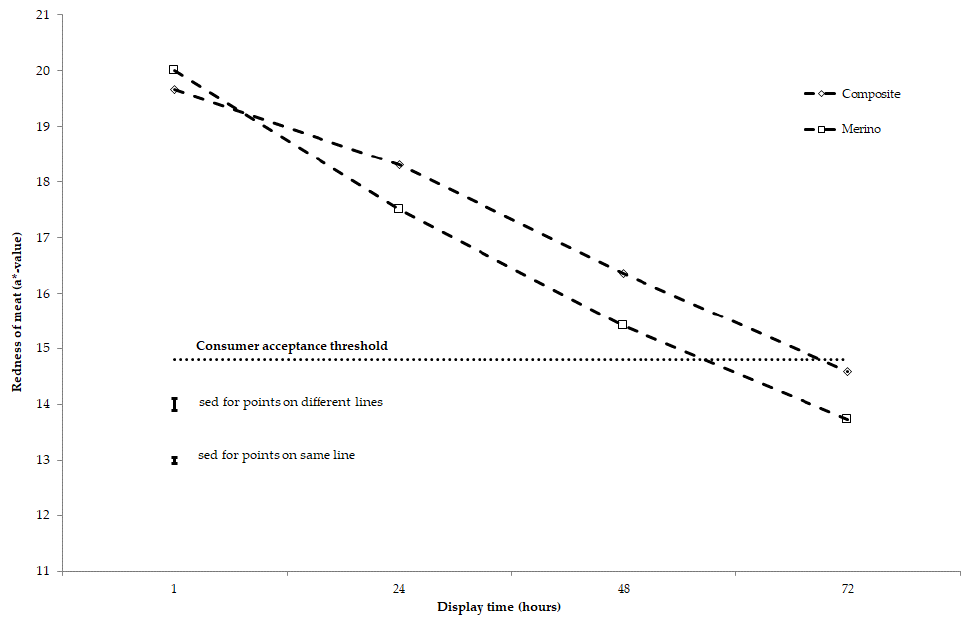
Figure 2. Effect of animal type (Composites vs. Merinos) on redness (a*-value) of muscle longissimus lumborum during 72 h of retail display under simulated refrigeration. Display time is the number of hours after muscle is cut and displayed for retail colour measurement. Sed denotes standard error of difference.